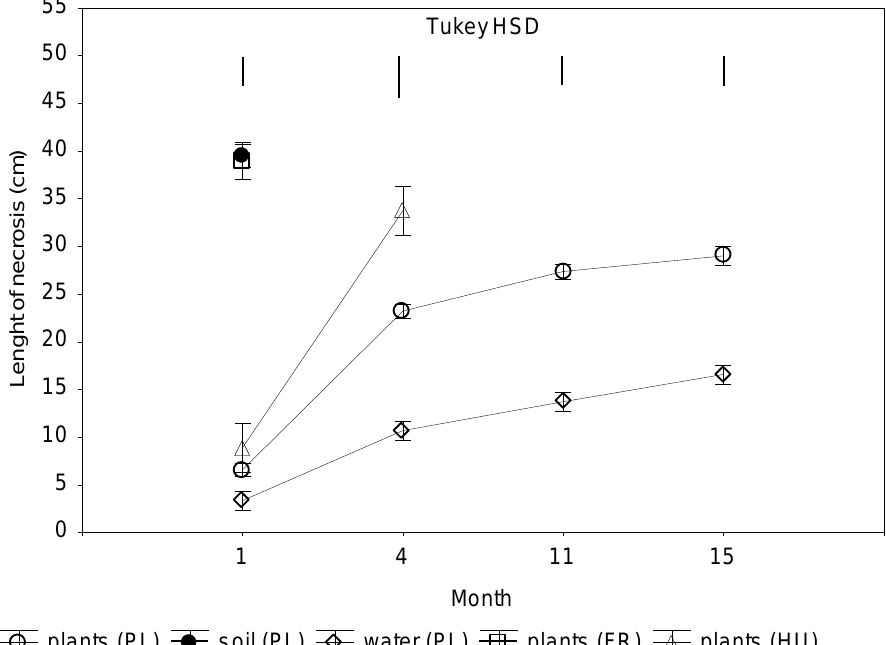
Figure 2. Colonization of shoots 2-year-old seedlings of Alnus glutinosa inoculated with Phytophthora × alni ( n = 15). Vertical bars at means showing SD. Tukey HSD — honestly significant difference calculated according to Tukey test at p = 0.05 for comparisons of the isolates group at each term of measurements.